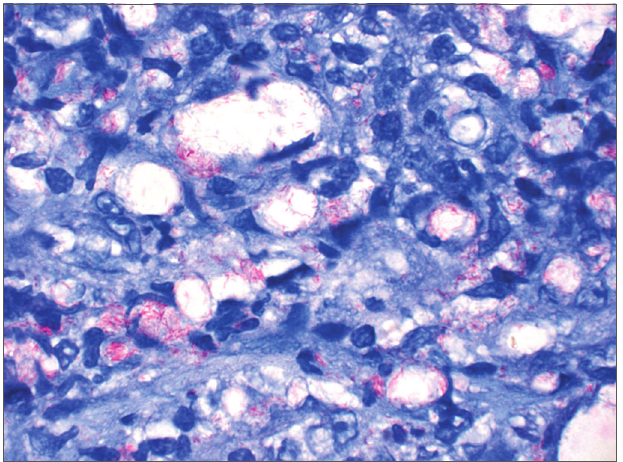
Figura 1. Lâmina com aumento de 1000x - coloração de WADE - Ri-